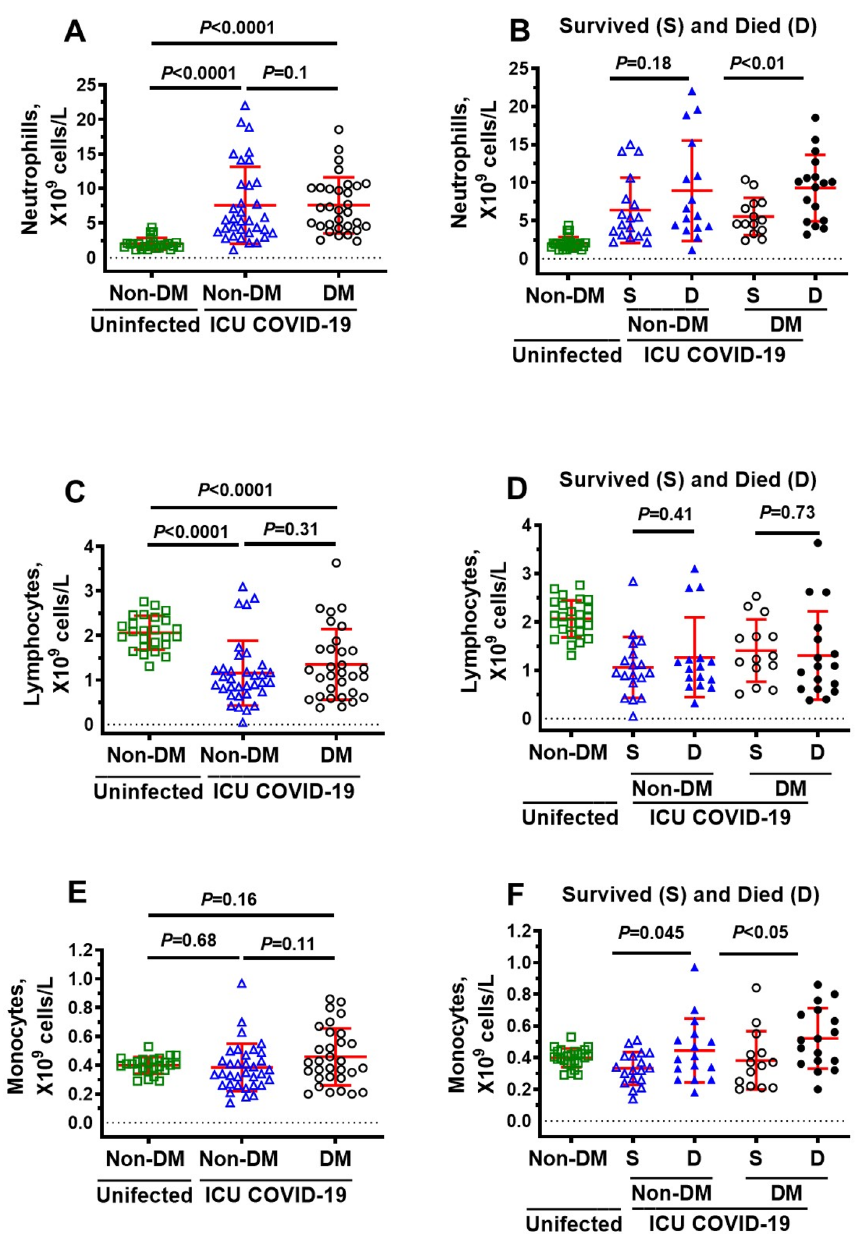
Figure 7. Blood levels of neutrophils, lymphocytes, and monocytes in ICU COVID-19 patients without diabetes mellitus (non-DM) and with diabetes (DM) and separated into those that survived and those that died. ( A ) Neutrophils levels in blood from non-DM and DM ICU COVID-19 patients were significantly higher than uninfected non-DM individuals. There was also a significant difference in blood neutrophils levels between non-DM and DM ICU COVID-19 patients. ( B ) No significant differences in neutrophils levels in blood from non-DM ICU COVID-19 patients that died and survived. However, there was a significant difference in blood neutrophils levels between DM ICU COVID-19 patients that survived and died. ( C ) Lymphocytes levels in blood from non-DM and DM ICU-COVID-19 patients were significantly higher than uninfected non-DM individuals. There was not a significant difference in lymphocytes levels in blood from non-DM and DM ICU COVID-19 patients. ( D ) No significant differences in blood levels of lymphocytes in non-DM and DM ICU COVID- 19 patients that died and survived. ( E ) Monocytes levels in blood from non-DM and DM ICU COVID-19 patients were not significantly higher than uninfected non-DM individuals. Monocytes levels in blood from DM ICU COVID-19 were also not significantly higher than of non-DM ICU-COVID-19 patients. ( F ) Significant difference in blood levels of monocytes in non-DM and DM ICU COVID-19 patients that died and survived. Data shown in ( A , C , E ) are mean ± S.E.M from n = 30 in uninfected non-DM individuals (26.6% females), n = 34 in non-DM (33.3% females) and n = 31 in DM (25.8% females) group. Data shown in ( B , D , F ) are mean ± S.E.M from n = 30 in uninfected non-DM individuals (26.6% females), n = 18 in non-DM survived (44.4% females), n = 16 in non-DM died (30.7% females), n = 14 DM in survived (28.6% females), and n = 17 in DM died (37.5% females) groups. Statistical significances are shown above data points on each